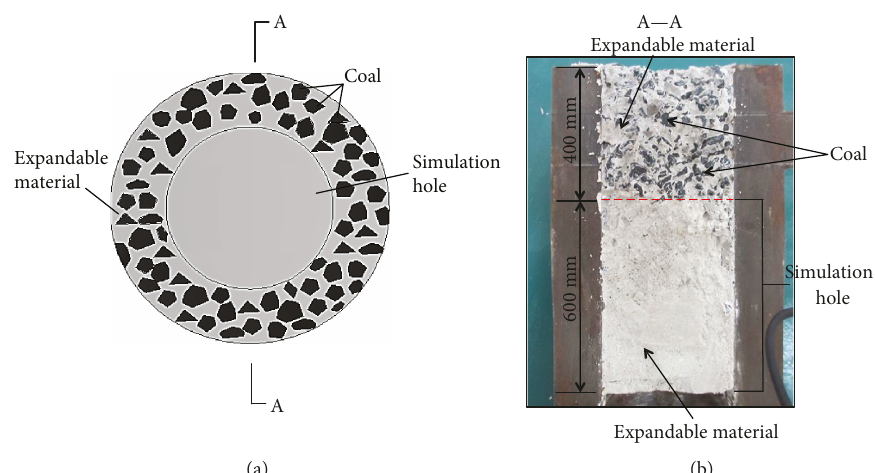
Figure 4: Model of induration of expandable material with high water content consolidated with coal masses: (a) schematic of borehole sealed by slurry and (b) model pro fi